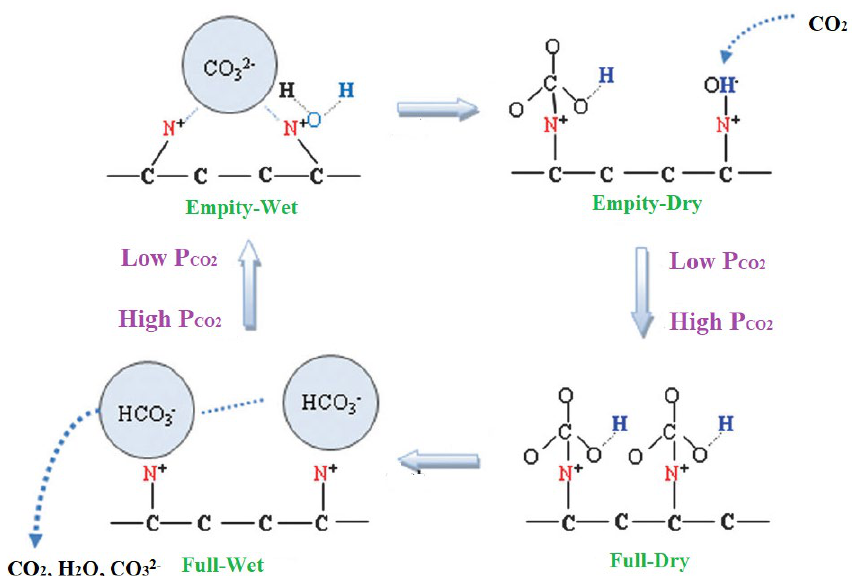
Figure 7. Reaction scheme of CO 2 adsorption/desorption for an anion-exchange resin. Adapted from [109] .